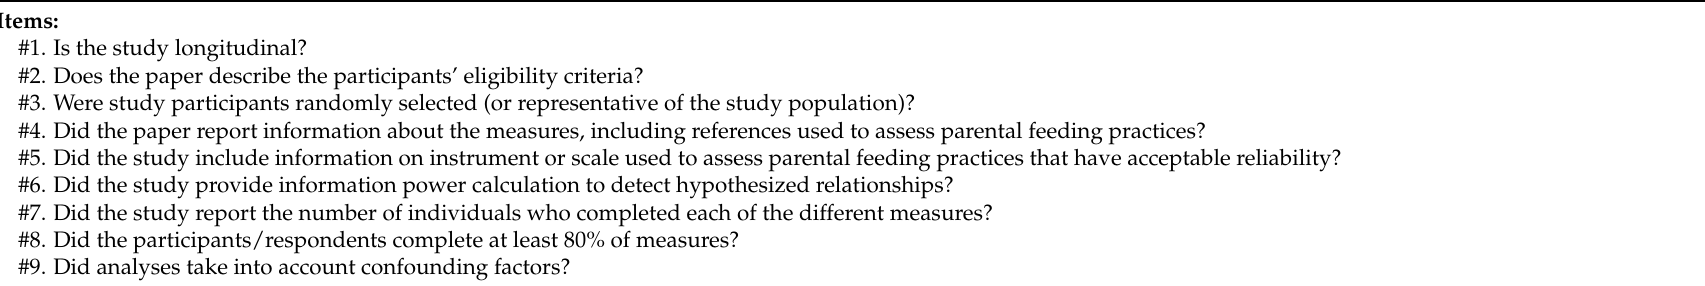
Table 1. Quality assessment of included quantitative studies using adapted ‘Strengthening the Reporting of Observational Studies in Epidemiology (STROBE)’ statement (n =